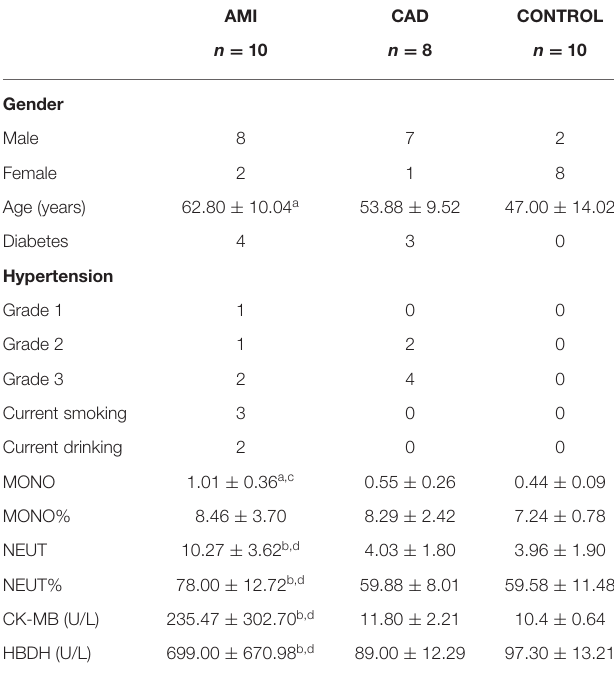
TABLE 1 | Clinical baseline characteristics of